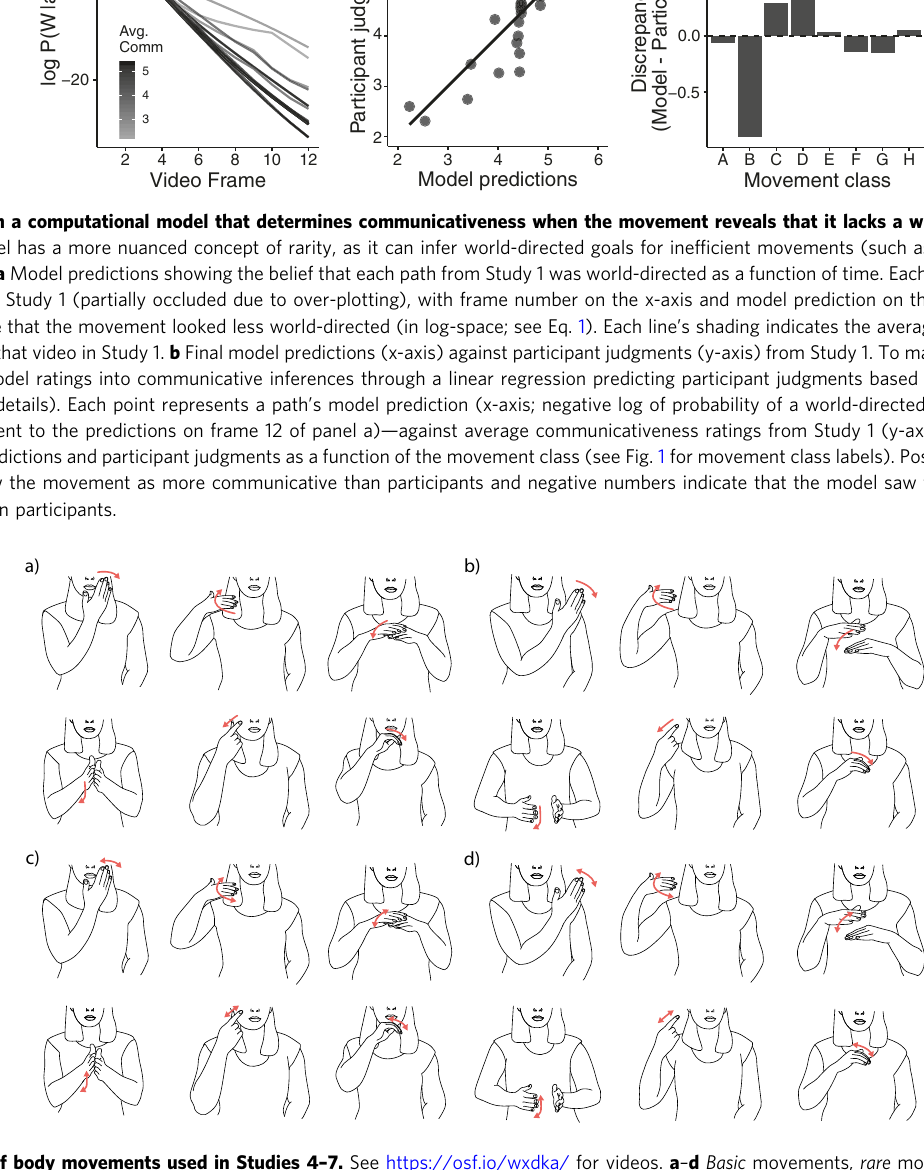
Fig. 4 Schematic of body movements used in Studies 4 – 7. See https://osf.io/wxdka/ for videos. a – d Basic movements, rare movements, repetitive movements, and rare + repetitive movements. The actor ’ s eyes were never visible and the face was always directed at the camera, preventing participants from relying on facial information. All videos were normed to ensure that they exhibited rarity and repetition. See SI for norming data on